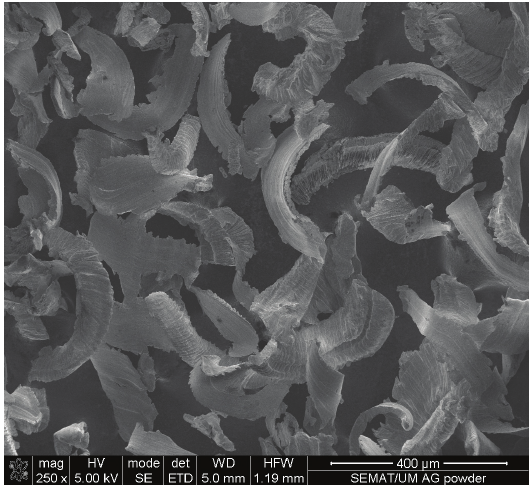
Figure 1. SEM micrograph showing the morphology of the silver alloy powders.